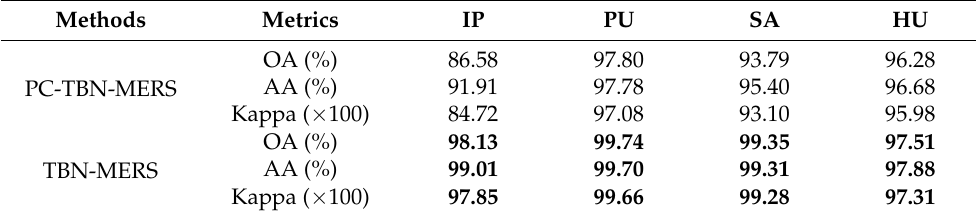
Table 8. Classification results of PC-TBN-MERS and